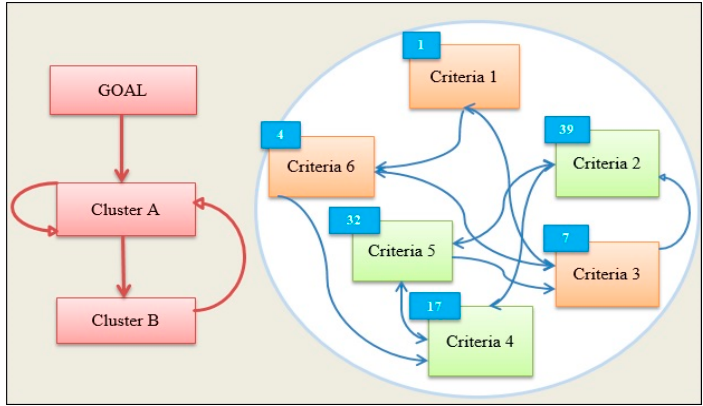
Figure 2. Feedback connections and loop in the ANP method.